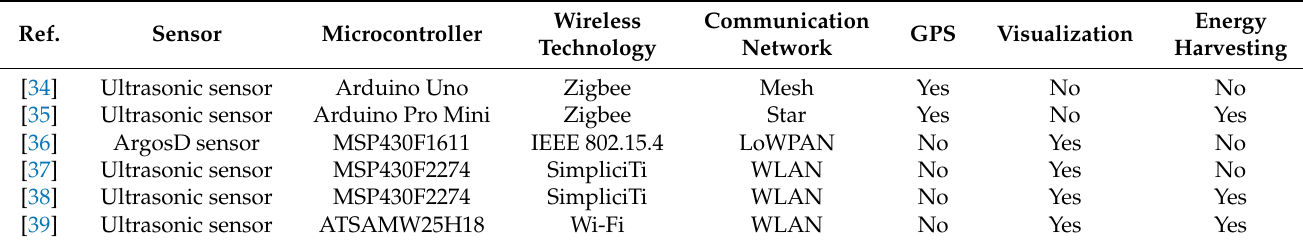
Table 3. Summary of WSN-based trash bin level monitoring